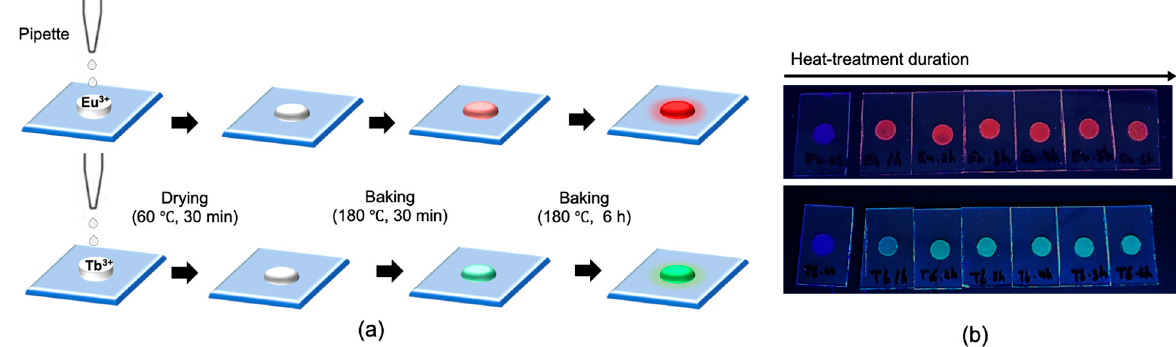
Figure 2. ( a ) Lanthanide LPSQs film fabrication process; ( b ) photographs of the fabricated luminescent films under a UV lamp ( λ = 365 nm). Thermal curing duration at 180 °C increases by 1 h from left to right.